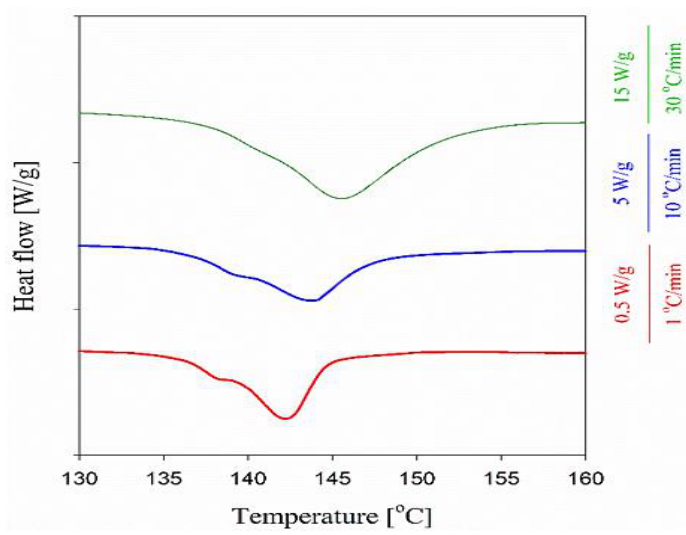
Figure 6. First heating thermograms (endo-down) of the nanocomposite, processed at 115 °C for 30 min, recorded at different heating rates.